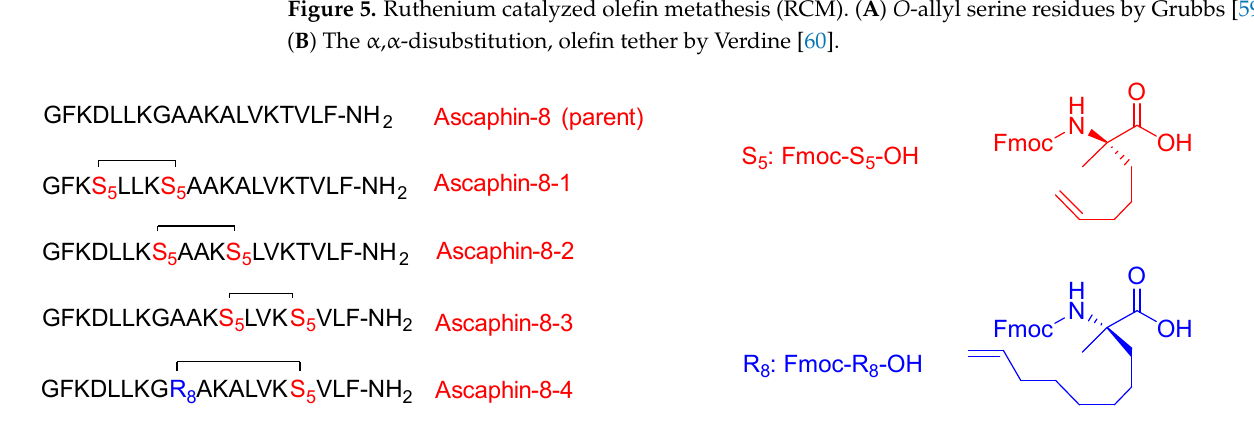
Figure 5. Ruthenium catalyzed olefin metathesis (RCM). ( A ) O -allyl serine residues by Grubbs [59]. ( B ) The α,α-disubstitution, olefin tether by Verdine [60].